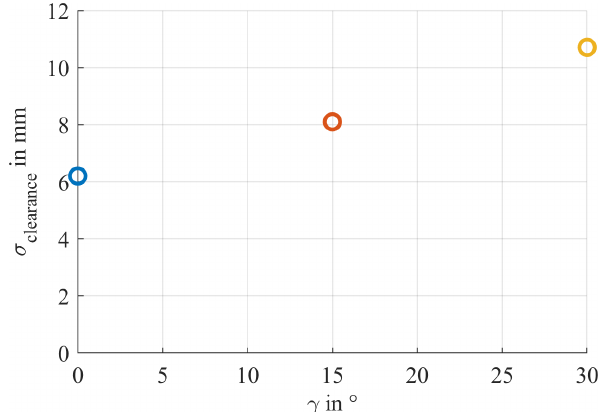
Figure 9. Standard deviation of the simulated tower–blade tip clear- ance from 10000 repetitions for different instances of angle γ